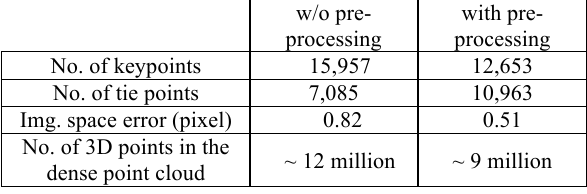
Table 2. Scenario A: results of image orientation without (left) and with (right) image pre-processing.